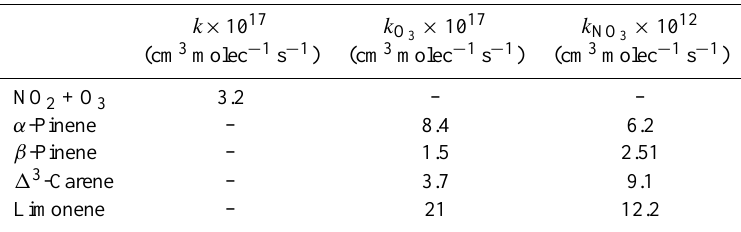
Table 1. Rate constants at 298K for NO 2 + O 3 (Sander et al., 2011) and for both O 3 and NO 3 with selected monoterpenes (Atkinson and Arey,